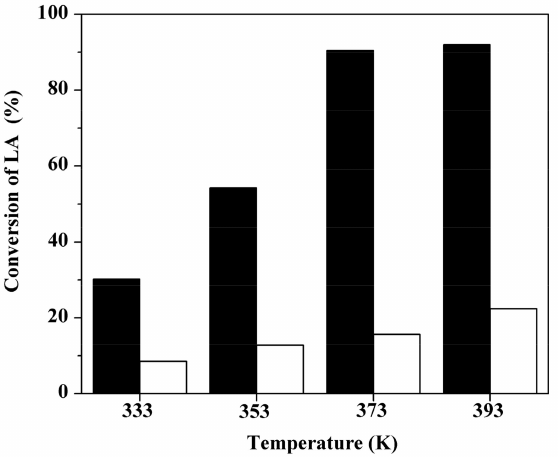
Figure 5. Conversions of LA over GC400 (black) and AC400 (white) at different reaction temperature. Reaction conditions: 1.16 g LA, 3.7 g n-butanol and 0.116 g catalyst, 4